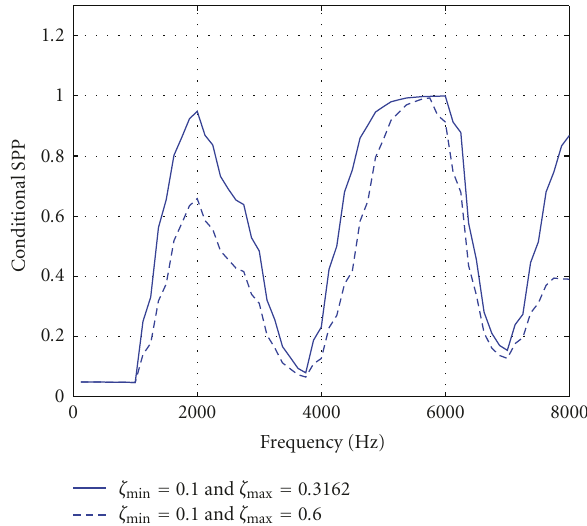
Figure 6: Conditional SPP with two distinct speech dominant